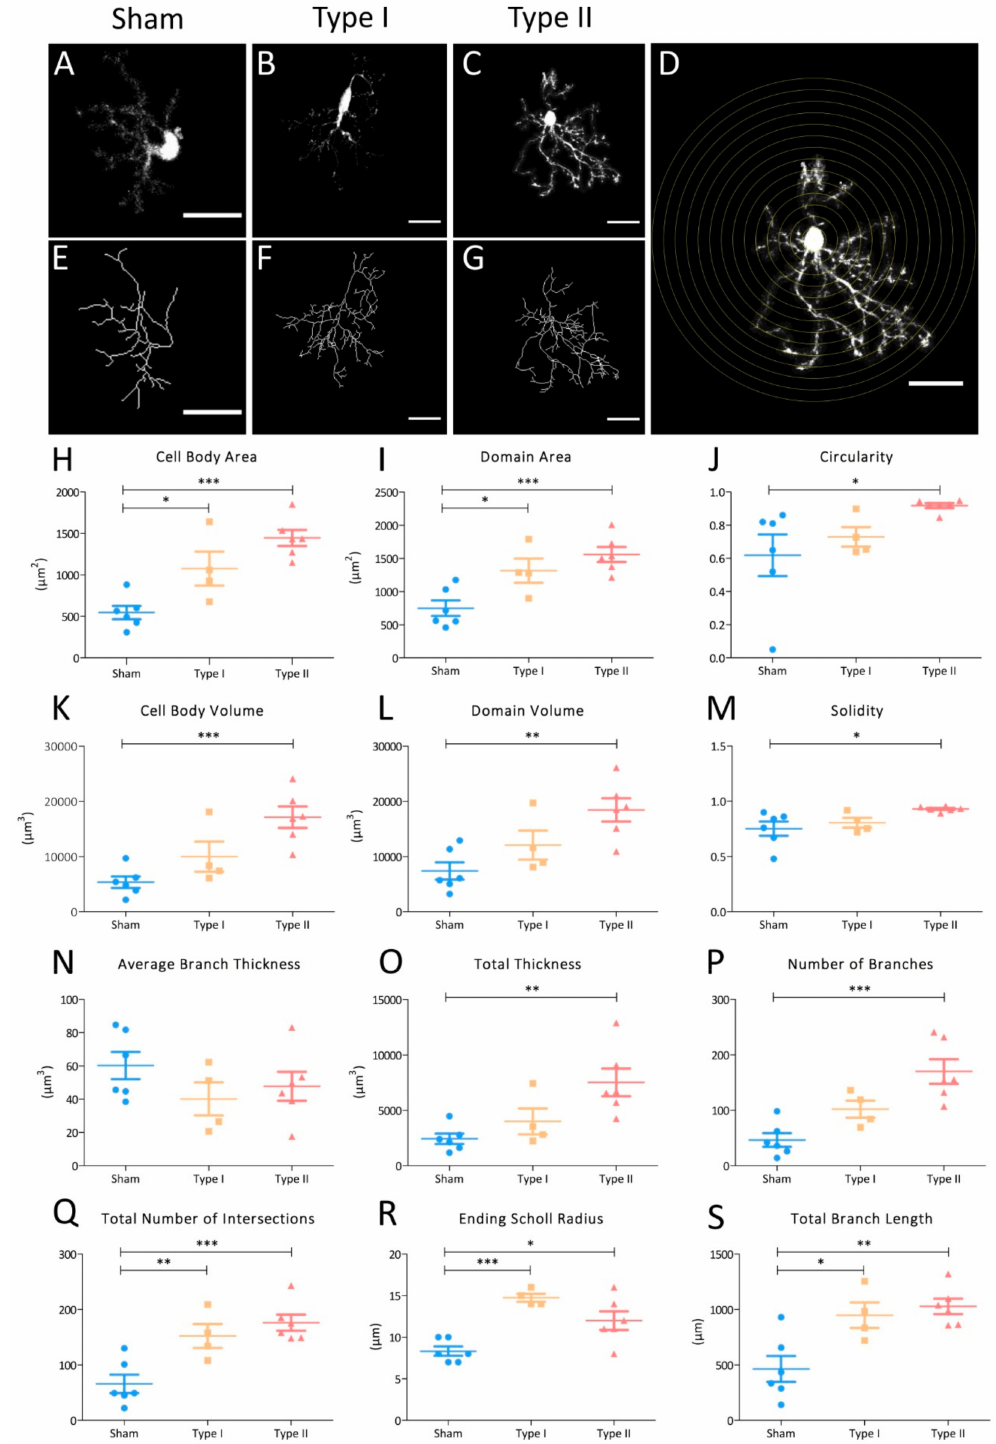
Figure 4. Morphometric parameters showing the shift of NG2-glia towards hypertrophy in the EAE brain. ( A – G ) Representative z-stack projection of StarTrack-labelled NG2-glia. Morphological analysis comparing sham NG2-glia ( A , E ) with both cell types identified in EAE mice: type I ( B , F ) and type II ( C , G ). Fill out images obtained once all paths were drawn using the Simple Neurite Tracer (SNT) plugin (NIH-ImageJ ( A – C ). Measurements of cell body area and volume, domain area and volume, circularity, solidity and thickness were acquired using this image. The respective rendered paths of the NG2-glia in filled out images ( E – G ). The number of branches were automatically measured from